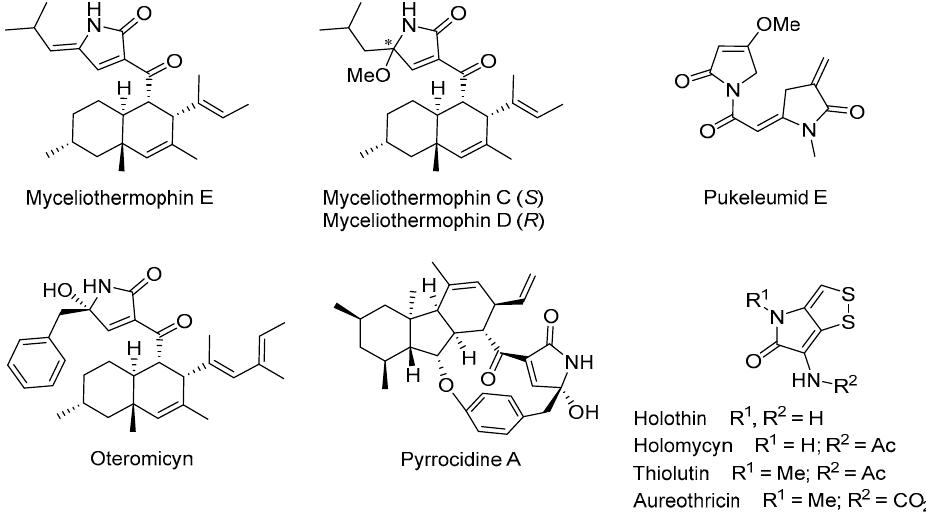
Figure 1. Bioactive natural 1,5-dihydropyrrol-2-ones (* denotes